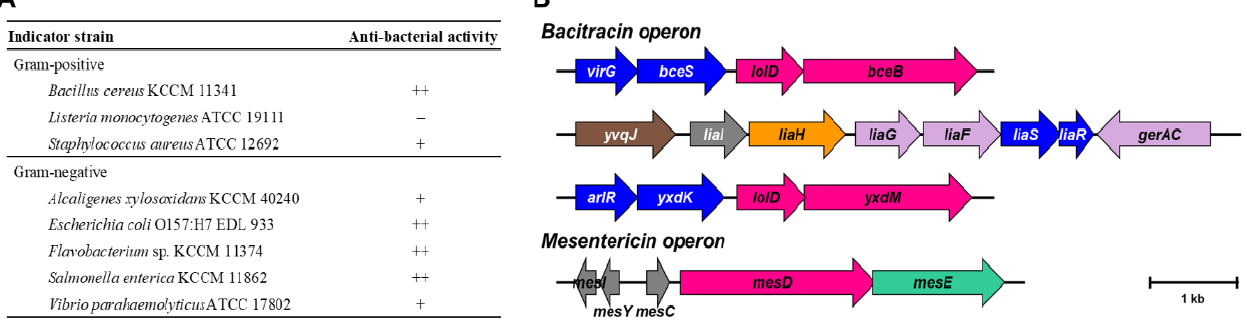
Figure 2. Antibacterial activity ( A ) and annotated bacteriocin-related genes ( B ) of B. siamensis strain B28.